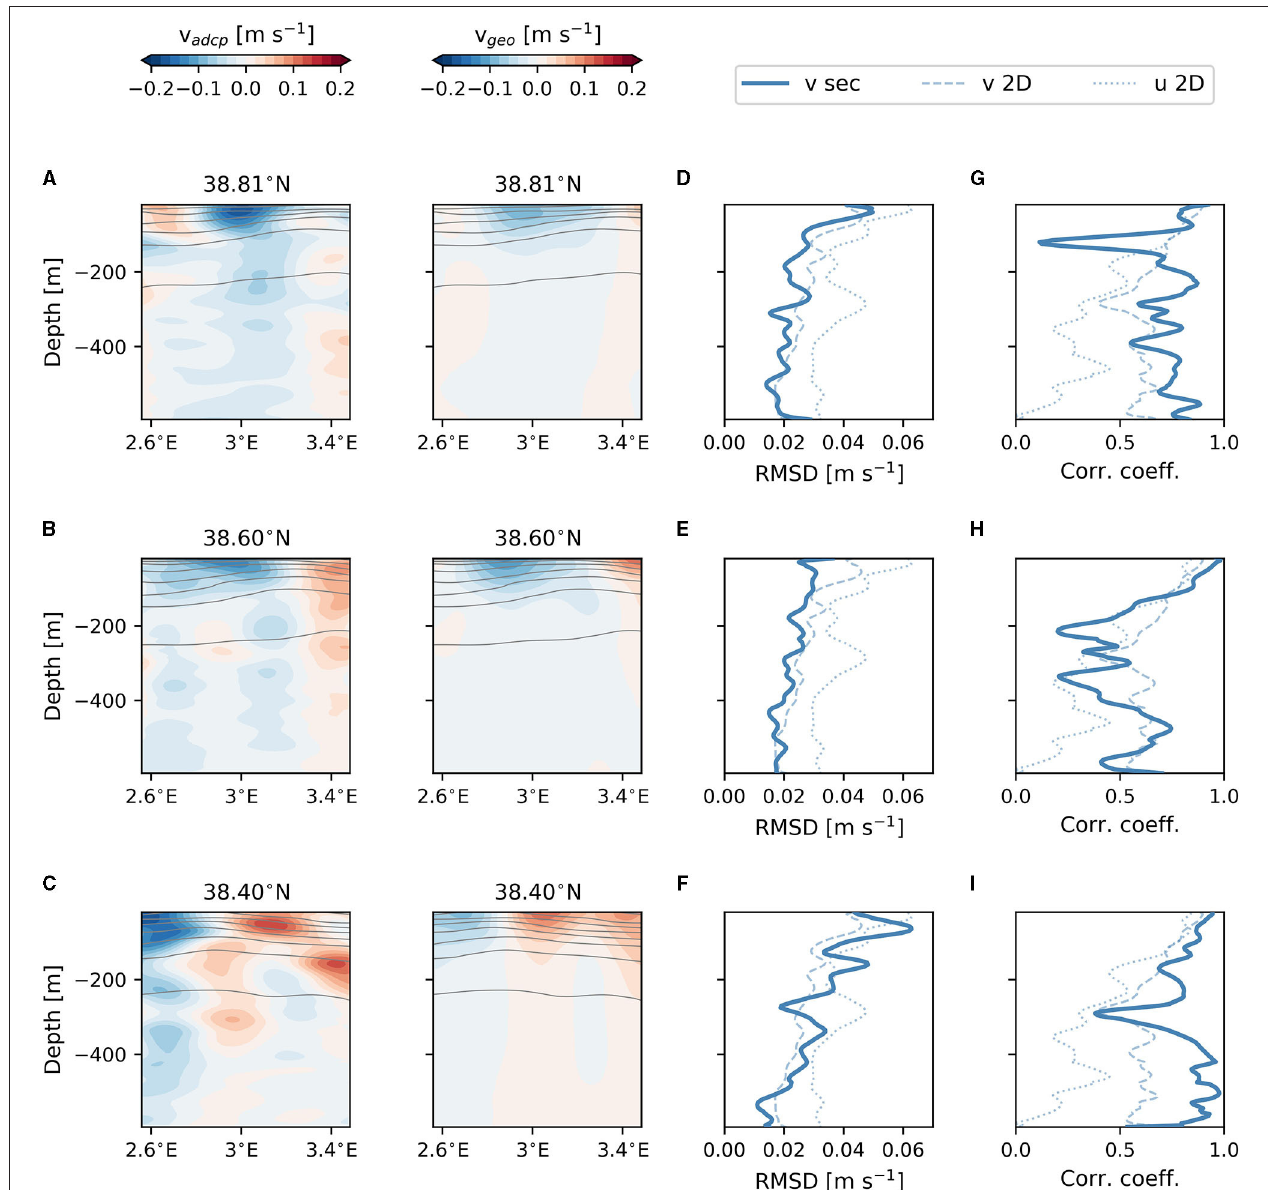
FIGURE 6 | Zonal sections along (A) 38.81 ◦ N, (B) 38.60 ◦ N, and (C) 38.40 ◦ N of the meridional component of the optimally interpolated ADCP velocity and geostrophic velocity calculated from CTD data. Gray contours represent the potential density anomaly (the contour at the bottom is the 29.0 kg m − 3 isoline and density decreases upwards with a contour interval of 0.2 kg m − 3 ). Solid lines in (D–F) are the vertical profiles of the root mean square differences (RMSD) between both velocity fields along (D) 38.81 ◦ N, (E) 38.60 ◦ N, and (F) 38.40 ◦ N. Solid lines in (G–I) are the vertical profiles of the correlation coefficient between the corresponding velocity fields. Dashed (dotted) lines represent the vertical profiles of the RMSD (D–F) and correlation coefficient (G–I) between the meridional (zonal) velocity components considering all data in each depth layer.